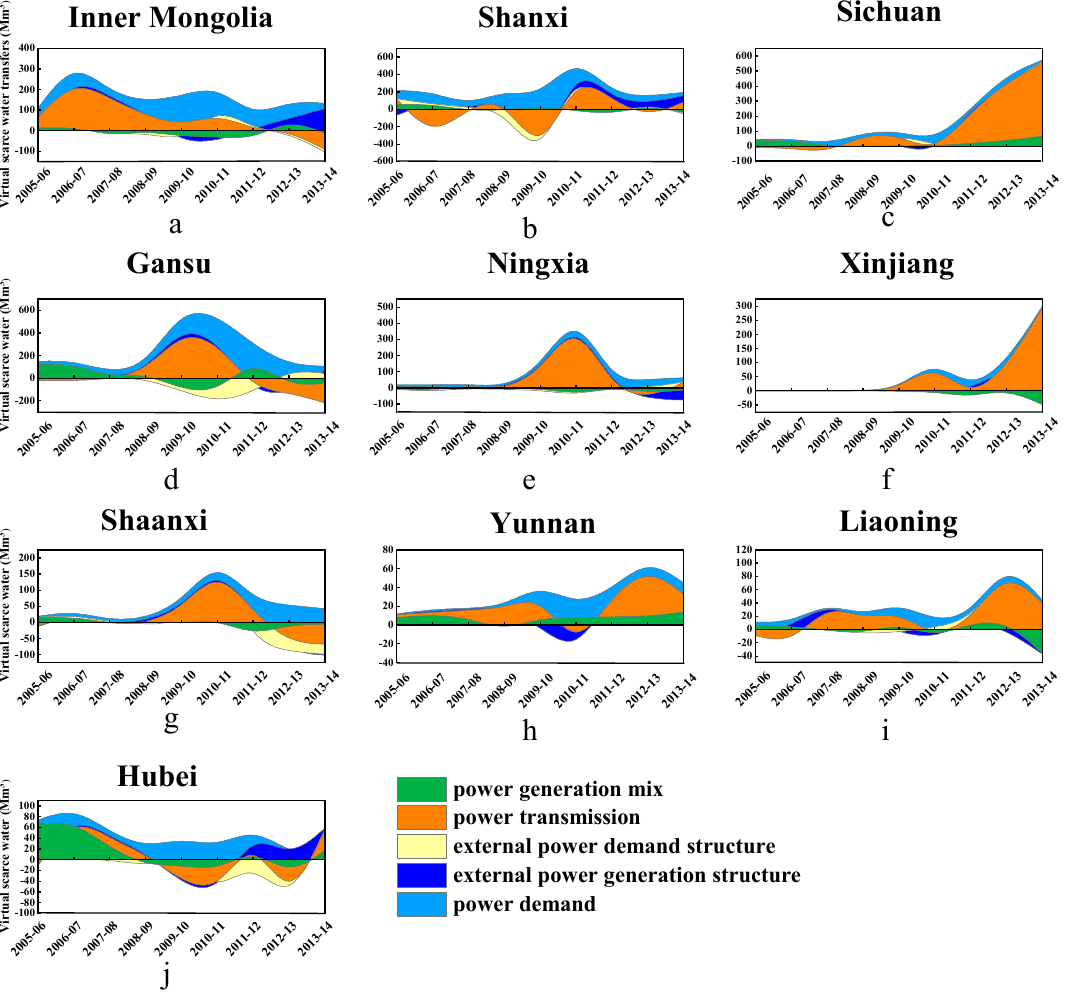
Figure 8. ( a – j ) The contribution of driving factors to the evolution of virtual scarce water transmission in the top ten exporters in 2014.